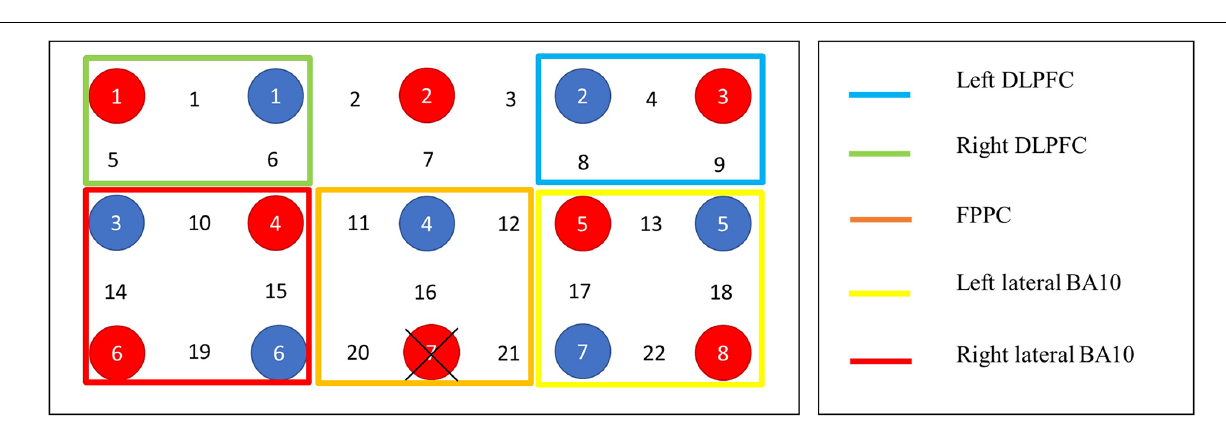
FIGURE 3 | Probe layout and channel groupings. Note. Distance between each source and detector represent 3 cm. Red circles denote detectors, blue circles denote emitters. Fpz marked at the